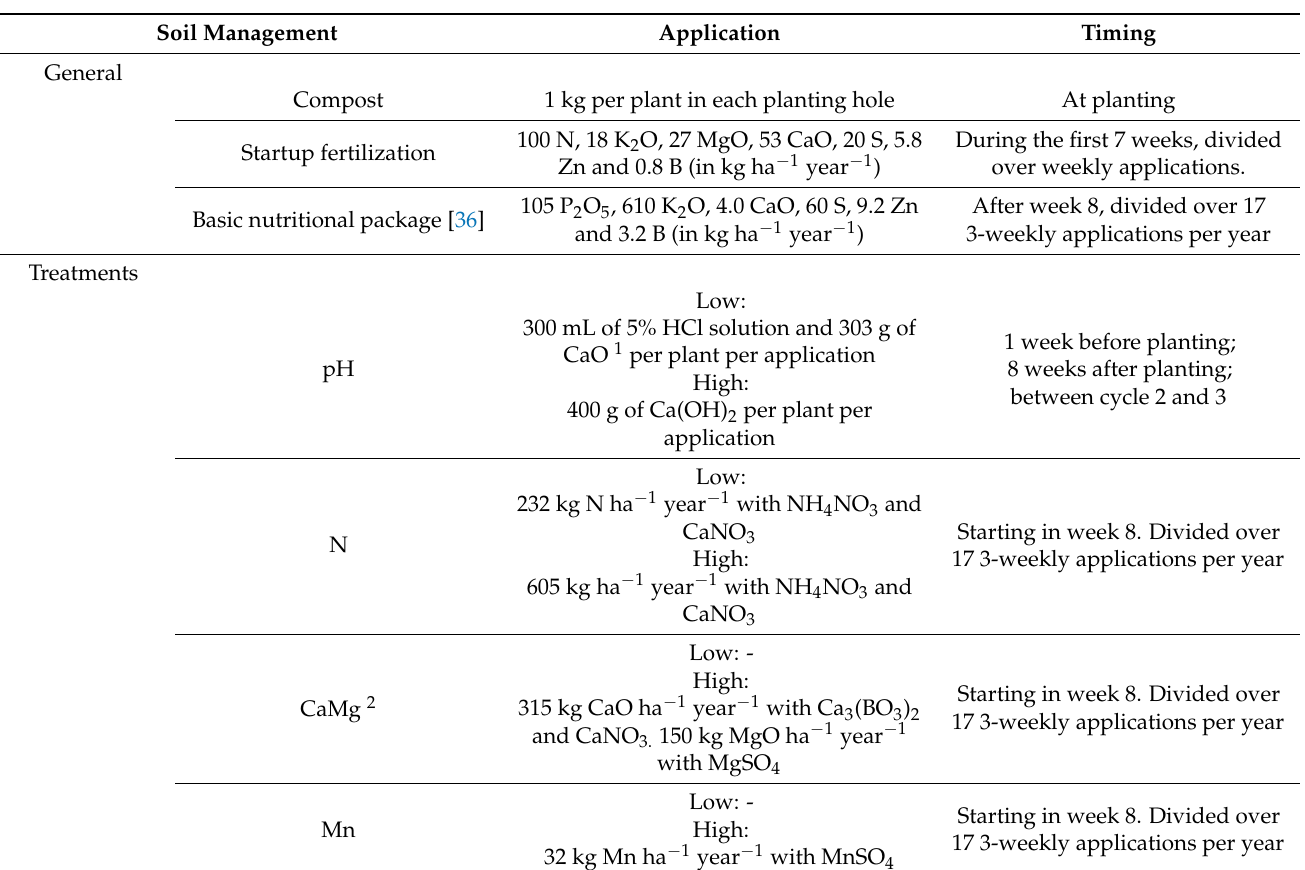
Table 1. Treatments in the factorial experiment to study the effect of managing soil chemical properties on FW in Gros Michel banana in the Costa Rican banana